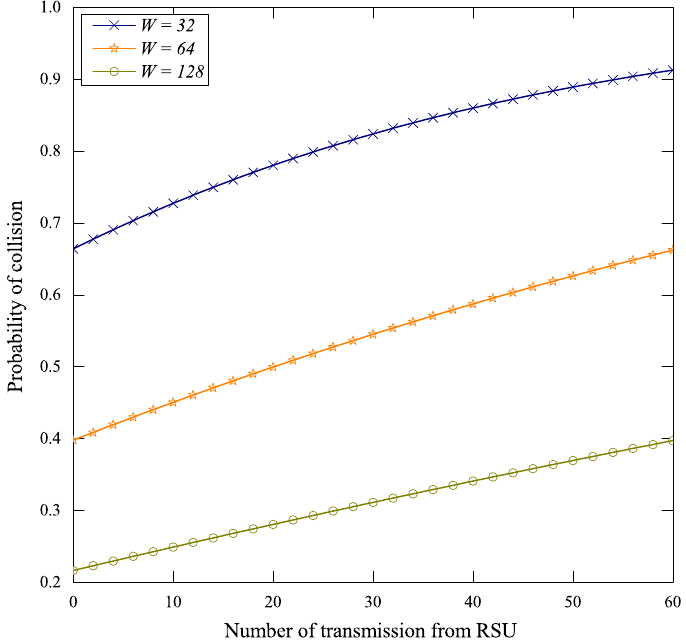
Figure 7. Probability of collision with different sizes of contention window (for N =